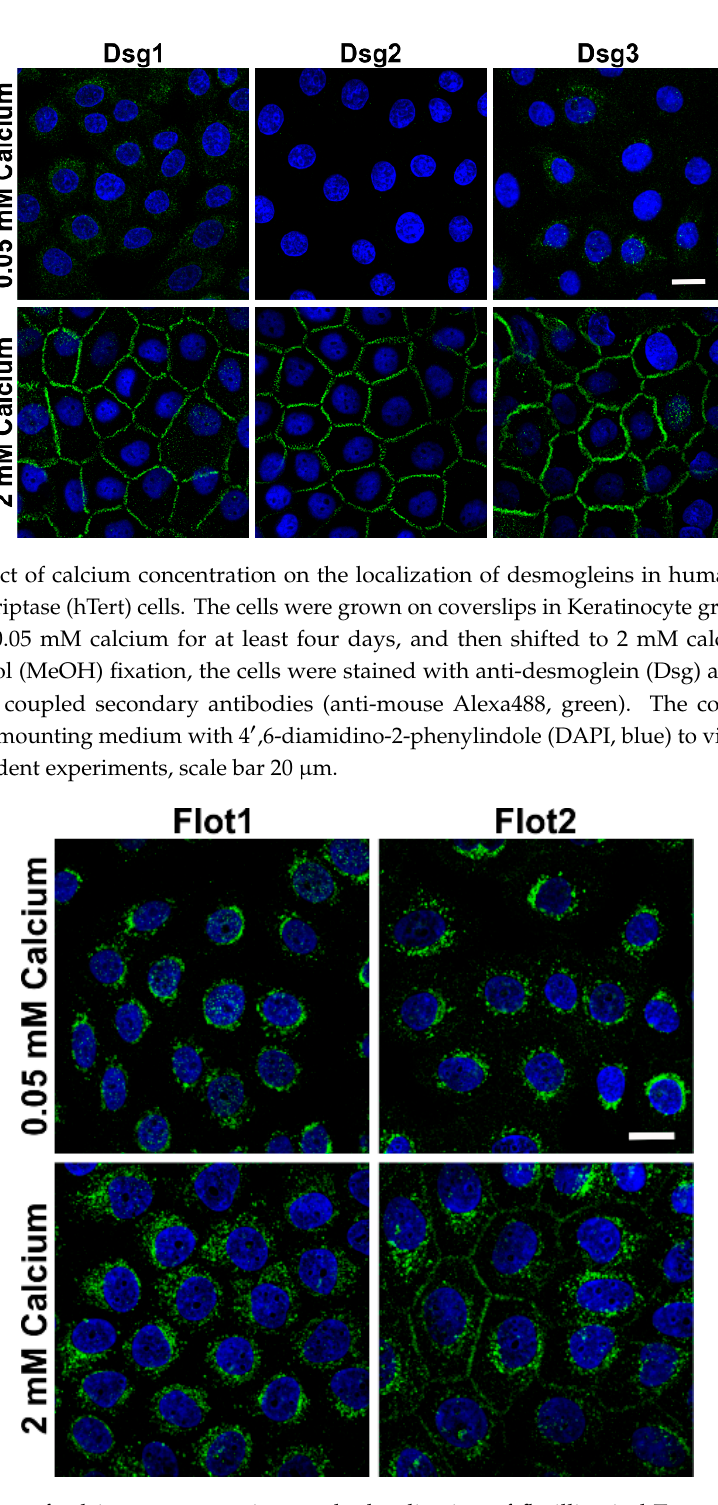
Figure 2. Effect of calcium concentration on the localization of flotillins in hTert cells. The cells were grown on coverslips in KGM with 0.05 mM calcium for at least four days, and then shifted to 2 mM calcium for 24 h. After MeOH fixation, the cells were stained with anti-flotillin antibodies and fluorochrome coupled secondary antibodies (anti-mouse Alexa488, green). The coverslips were mounted in a mounting medium with DAPI (blue) to visualize nuclei. n = 4 independent experiments, scale bar 20 µm.